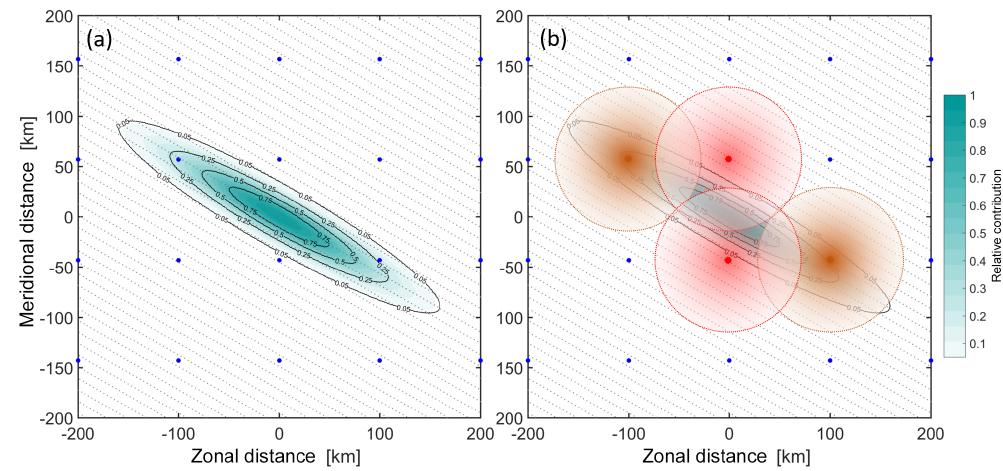
Figure 4. A 2-D schematic illustrating the motivation underlying our sampling approach. See text for further